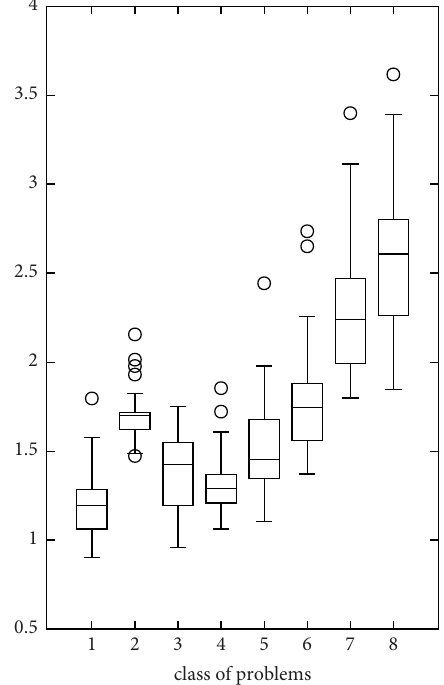
Figure 1: Boxplots of MMD values (minimum, lower quartile, median, upper quartile, maximum, and outliers) for the sets of 40 instances for the eight classes of SCP1.